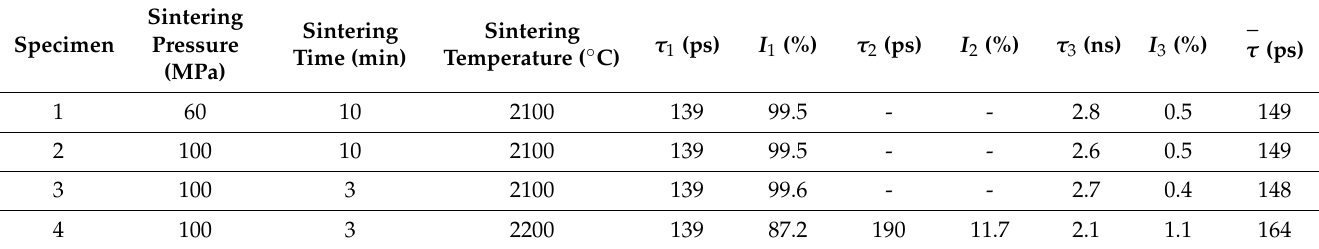
Table 2. Measured positron lifetime in the preceramic paper-derived SiC f /SiC composites.